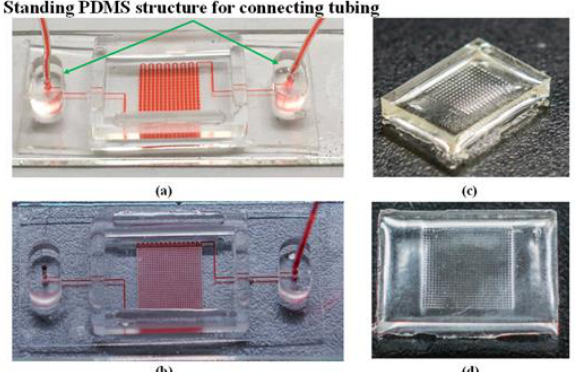
Figure 6. Using partial-curing PDMS bonding to create hybrid microfluidic chip with sufficient bonding strength to allow fabrication of MLAs of high density: ( a ) hybrid chip used for creation of MLAs based on Design I; ( b ) hybrid chip used for creation of MLAs based on Design II; UV adhesive casting applied against hybrid microfluidic chip in Figure 6a,b; ( c ) UV adhesive mold based on Design I; and, ( d ) UV adhesive mold based on Design II.